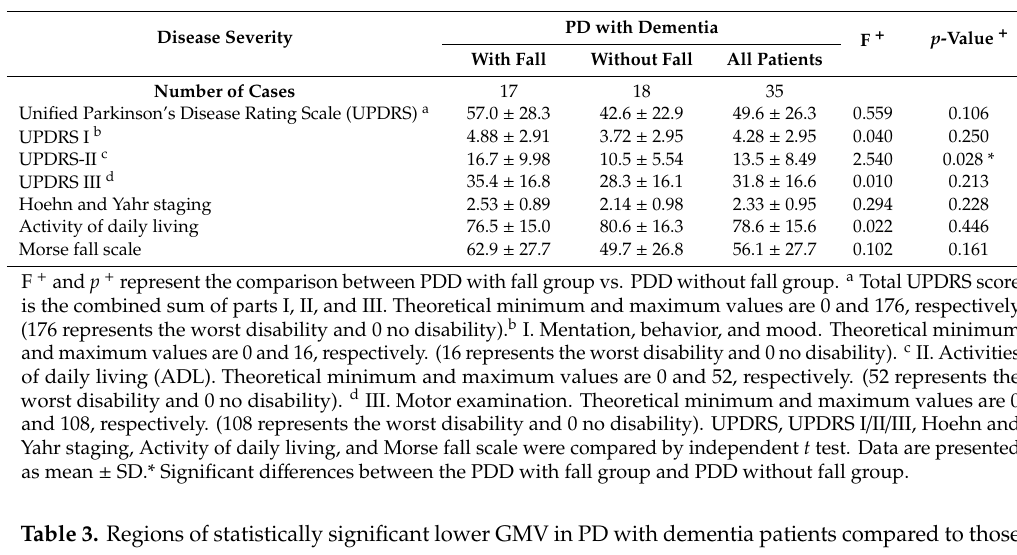
Table 2. Disease severity of PDD patients.